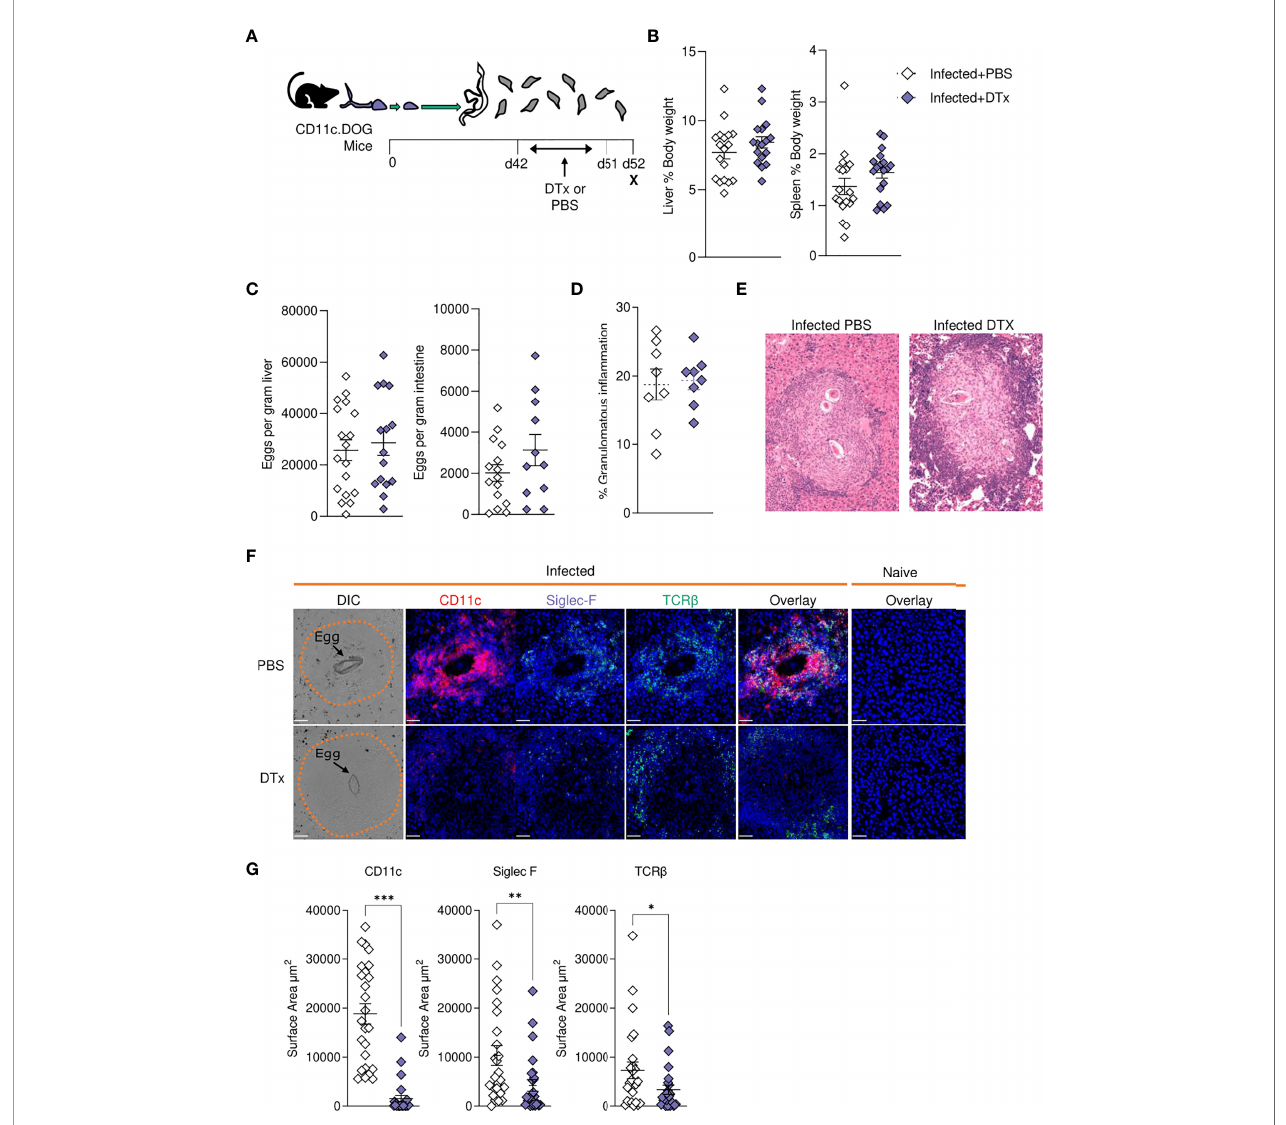
FIGURE 6 | CD11c depletion disrupts granulomatous pathology during S. mansoni infection. (A) Schematic of infection setup. CD11c.DOG mice were infected with 40 S. mansoni cercariae with CD11c + cells depleted via Dtx administration on days 42-51, and mice culled at d52. (B) Liver and spleen weights for infected mice with data represented as a proportion of total body weight. (C) The total number of schistosome eggs per gram of liver or intestinal tissue. (D) Quanti fi cation of granulomatous in fl ammation. (E) Representative images of hepatic granulomas stained with H&E. (F) Representative confocal microscopy granuloma images, with staining for CD11c, Siglec-F and TCR b . First column showing differential Interference Contrast (DIC) images, with eggs indicated by arrows and dotted lines outlining granuloma periphery. (G) Quanti fi cation of positive Siglec-F, CD11C and TCR b staining. Data are from a single experiment (D, E, F&G) or pooled from 3 (A – C) 3 separate experiments. Signi fi cance calculated by unpaired T-test. Data presented as mean +/- SEM. *p < 0.05, **p < 0.01, ***p <